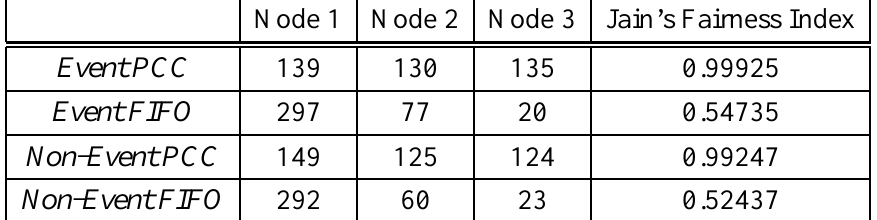
Table 1. Packets successfully received from different sensors in a chain